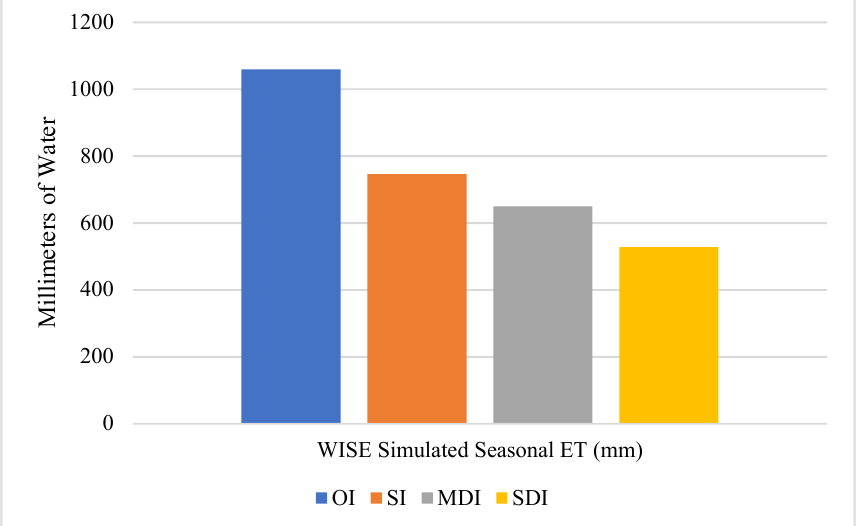
Figure 8. WISE simulated alfalfa ET c (2020 season) from over, standard, moderate deficit, and severe deficit irrigation levels.